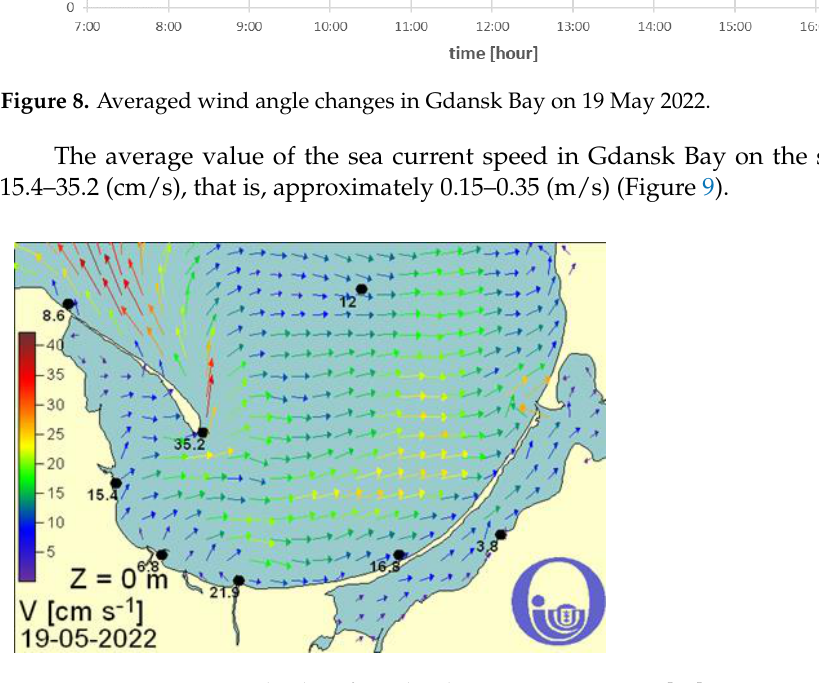
Figure 9. Sea current speed values for Gdansk Bay on 19 May 2022 [25].